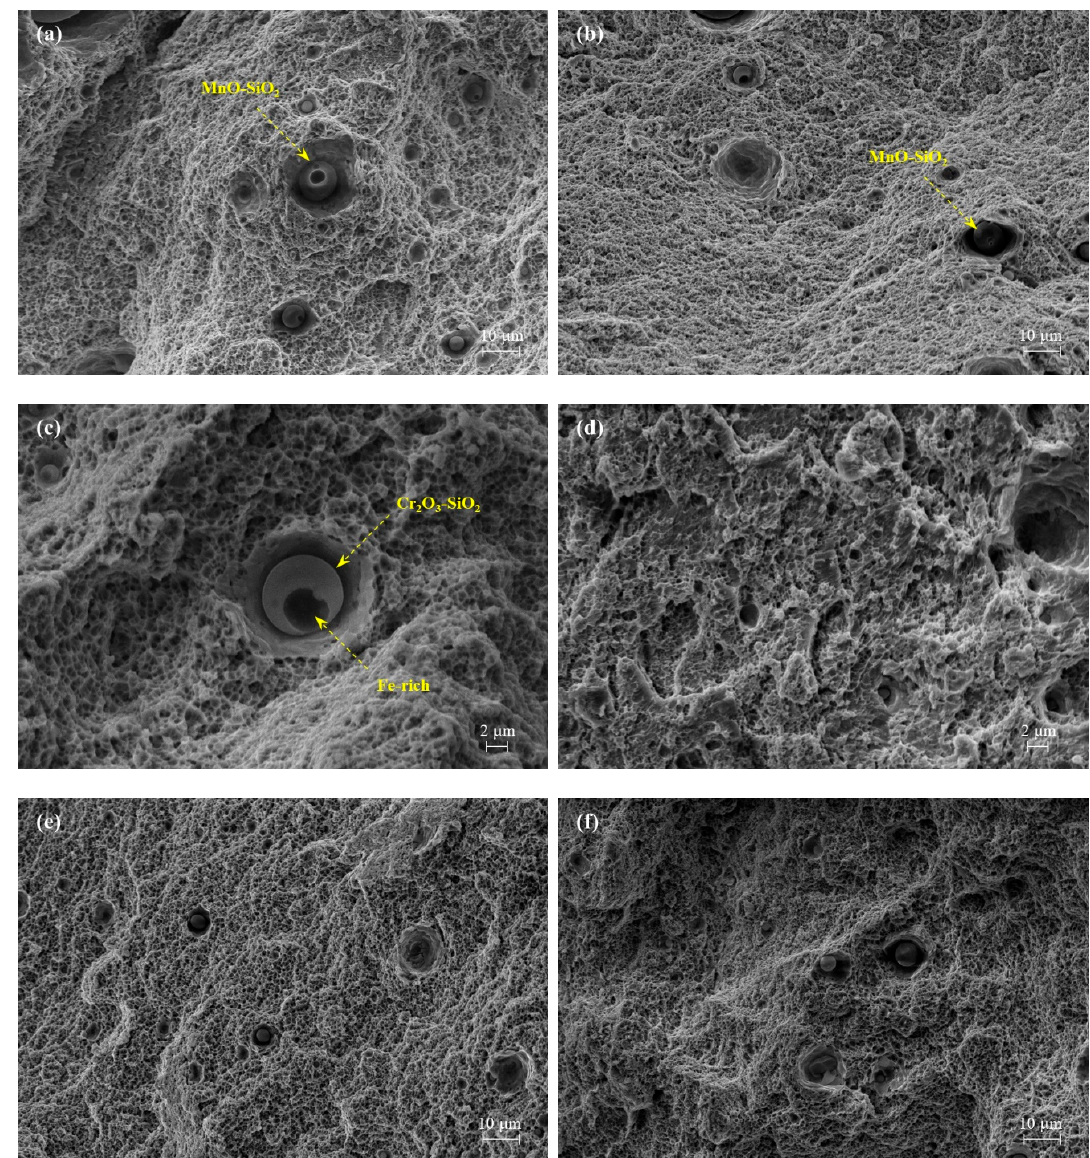
Figure 14. SEM fractographs of ( a ) as-built W-1 steel, ( b ) as-built and tempered W-2, ( c ) as-built W-3, ( d ) as-built W-4 alloys, ( e ) as-built W-2 and ( f ) quench and tempered W-3.